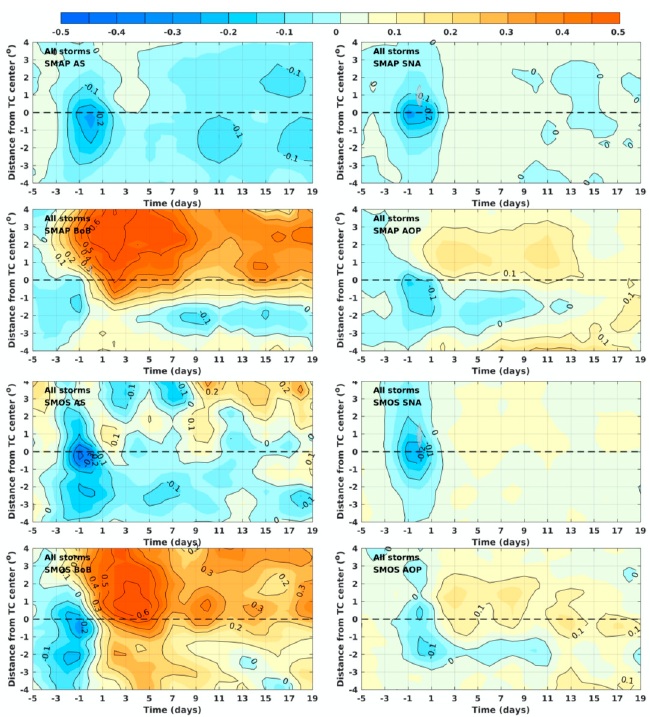
Figure 16. Along-track averaged composite of SSS anomaly relative to the reference SSS calculated with SMAP swath daily data (psu) and SMOS swath daily data (psu) for basin AS, BoB, SNA and AOP. Both the SMAP and SMOS SSS associated with high surface wind are removed. The gray shading indicates the region where more than 30% of the SSS pixels are removed. The y-axis is the cross-track ±4° to the right and left of the track. Composite SSS anomaly along-track ±4° to the center is averaged from days − 5 to 20.